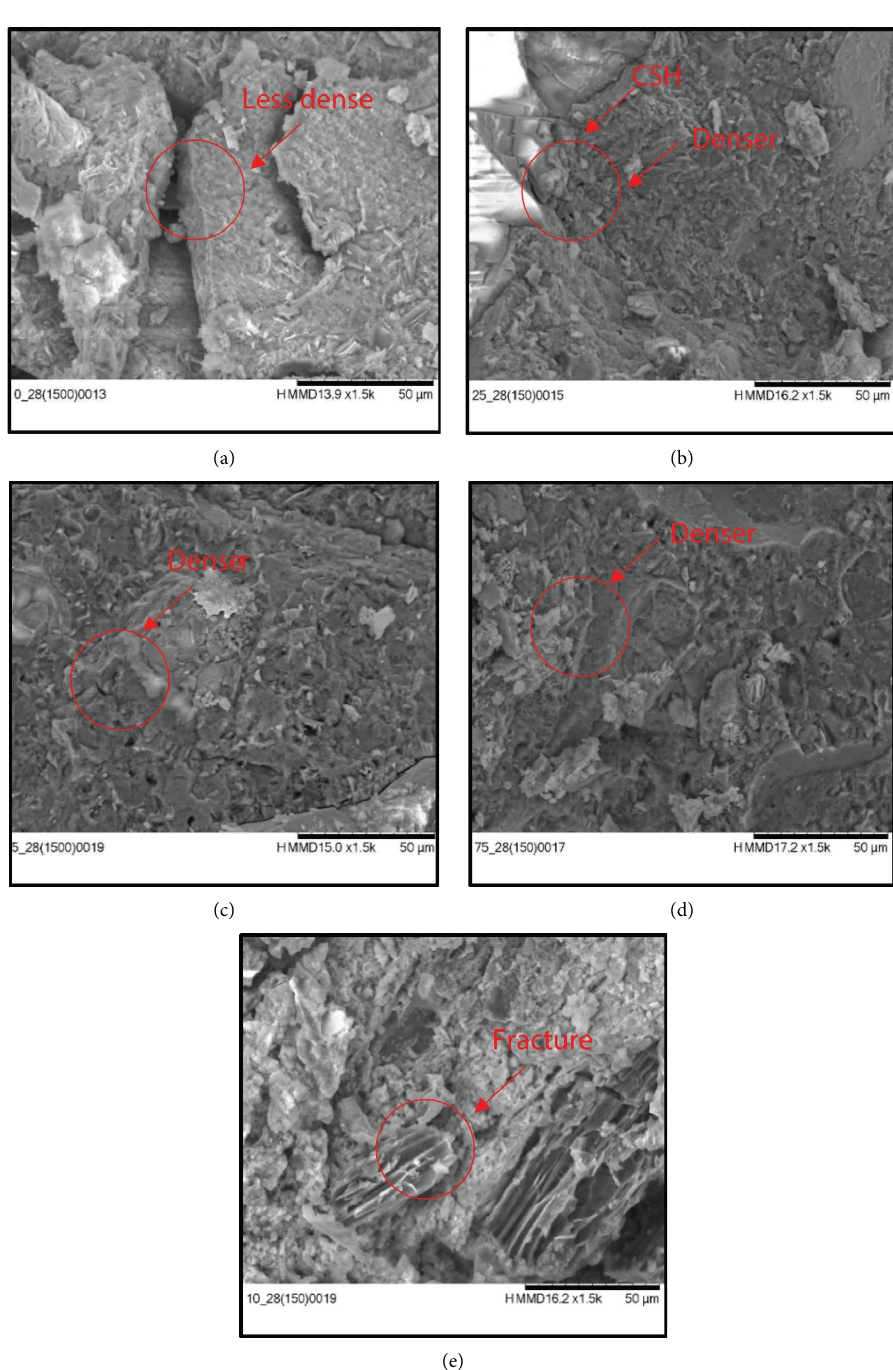
Figure 12: SEM micrographs of mortar on day 28 at 50 micron scale with 1500 magnifcation: (a) 0% POFA, (b) 2.5% POFA, (c) 5% POFA, (d) 7.5% POFA, and (e) 10%